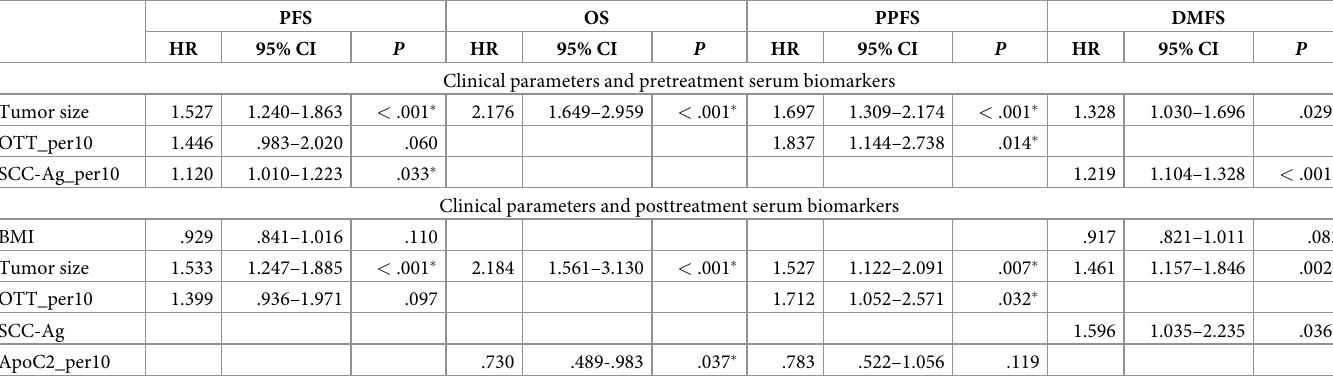
The correlation between pretreatment serum biomarkers and clinical variables is shown in Table 5. Pretreatment SCC-Ag, but not ApoC-II, was positively correlated with tumor size ( P < 0.001). Table 4. Pre-and posttreatment biomarkers and clinical parameters best-fit model in Multivariate analysis for PFS, OS, PPFS, and